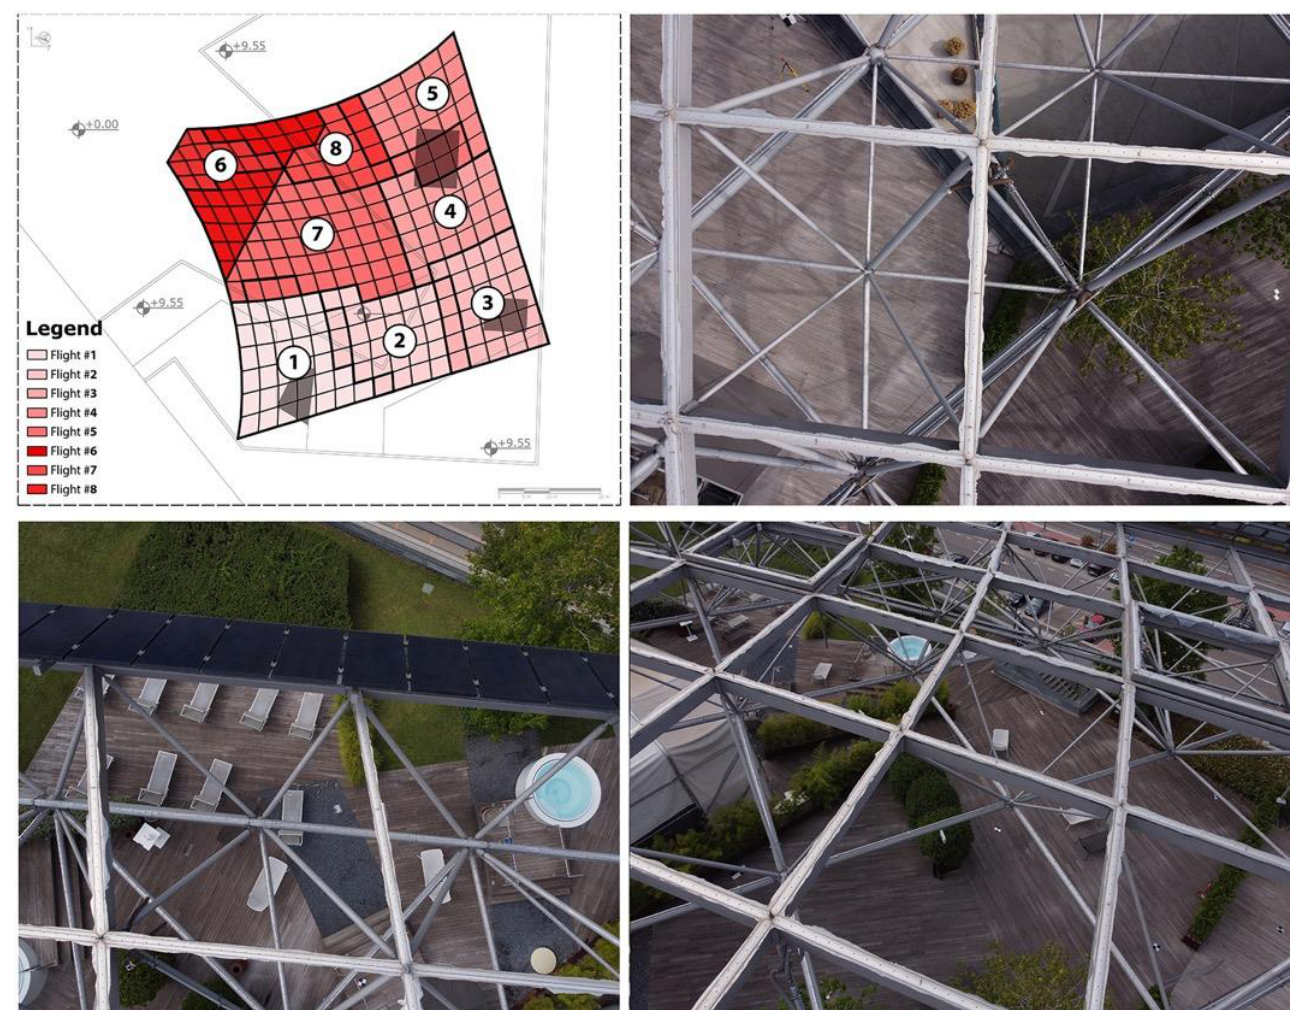
Figure 5. RPAS schema with related photogrammetric blocks acquired from the eight flights and three images (two nadiral and one oblique from block 4) with a high contrast between the structure data and background.